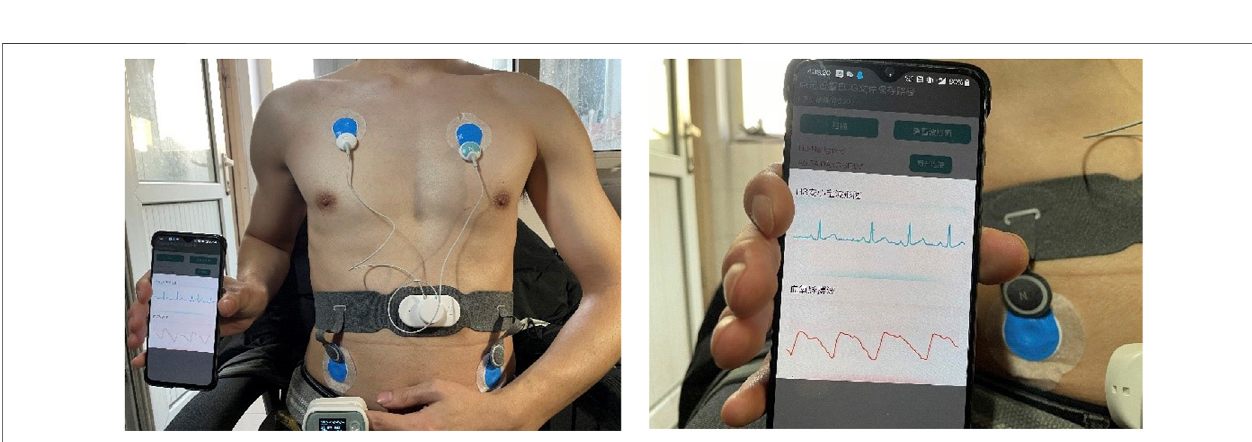
FIGURE 5 | Schematic diagram of device